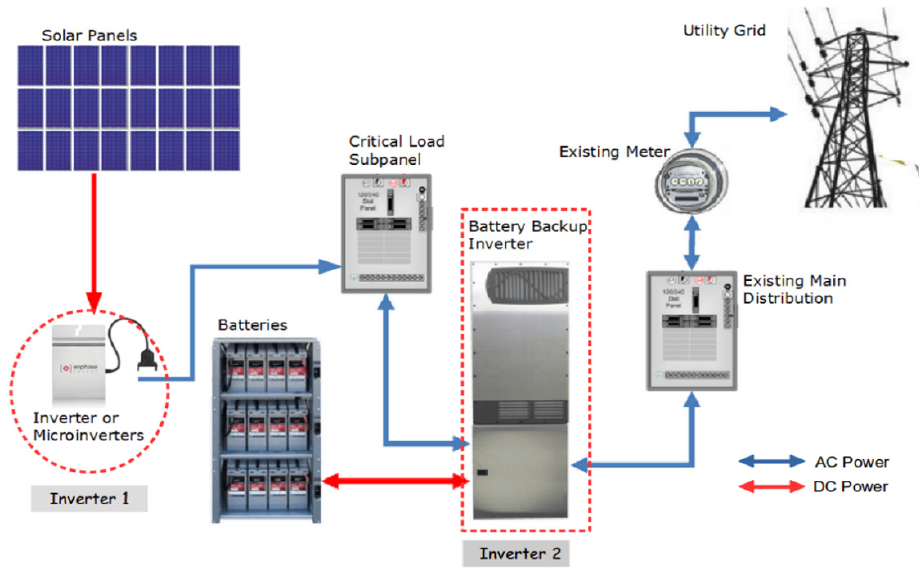
Figure 5. Existing practice for grid tied PV-battery systems with unnecessary inverter stages [44].